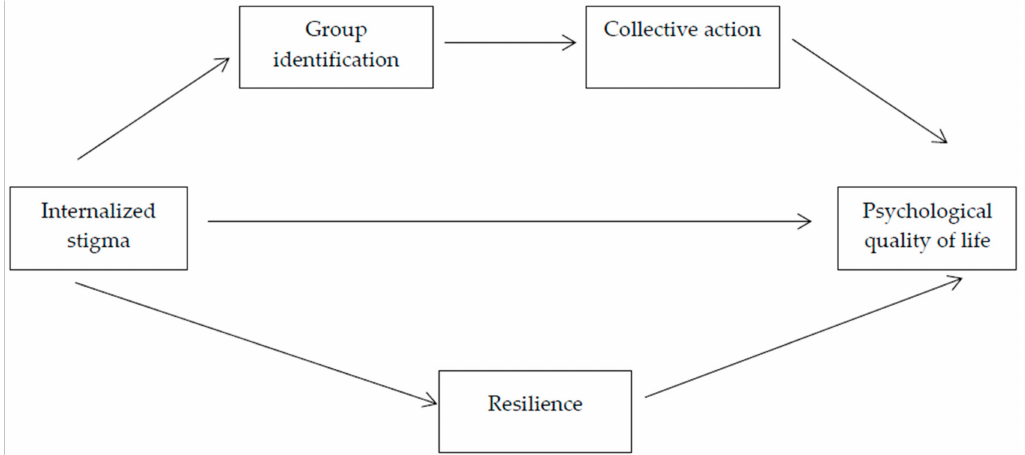
Figure 1. Model of psychological quality of life in people with